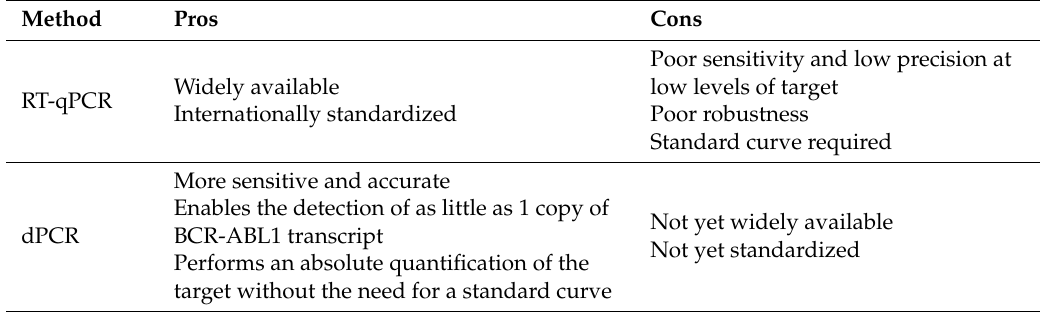
Table 1. Summary of the main advantages and disadvantages of gold standard (RT-qPCR) and